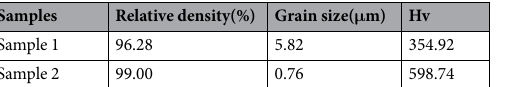
Table 1. Relative density, grain size and Vickers microhardness of the sintered W-Y 2 O 3